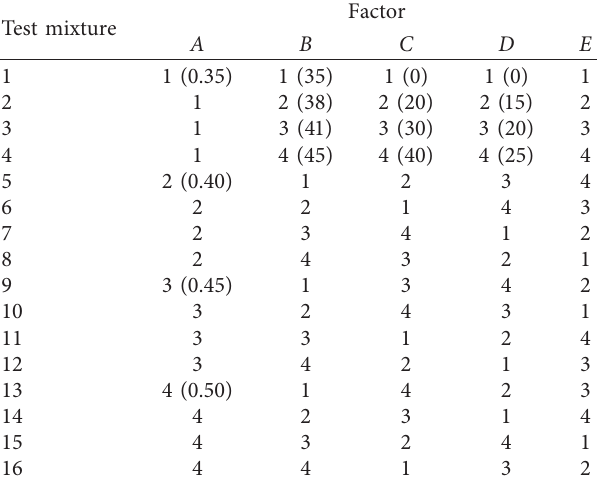
Table 8: Mixture ratio of orthogonal tests. Test